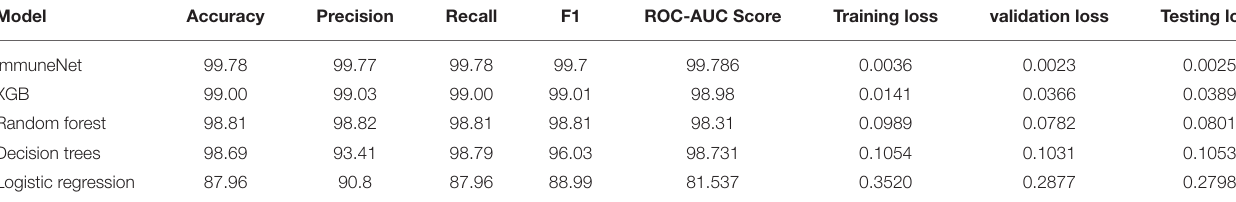
TABLE 9 | Comparison of models based on respective evaluation metrics for CIC IDS 2018. Model